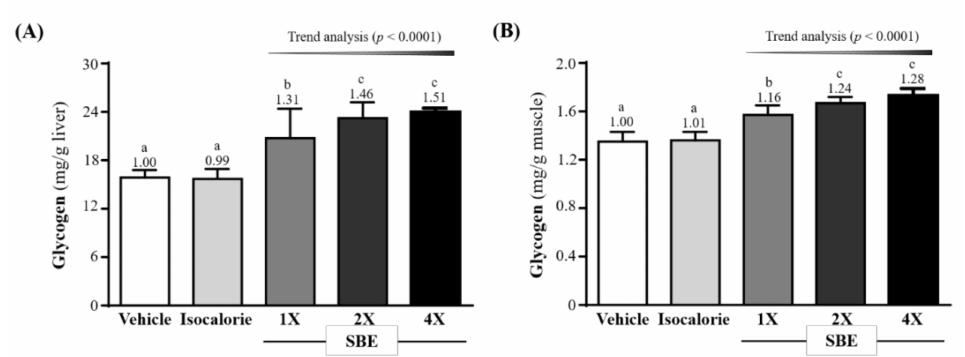
Figure 3. Effect of supplementation with SBE on ( A ) liver and ( B ) muscle glycogen. Data are expressed as mean ± SD for n = 10 mice per group. The different superscript letters (a, b, c) above each bar indicate a significant difference at p < 0.05.